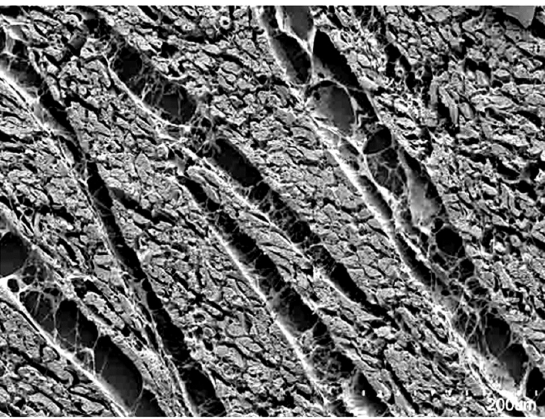
Figure 1. The scanning electron micrograph, taken from a sub-volume of the ventricular wall, shows how the individual cardiomyocytes are aggregated together by the endomysial component of the fibrous matrix into units that are separated by perimysial clefts containing loose connective tissue. There is, however, no uniformity in the thickness of the aggregated units, which can be seen to be heterogeneous and interconnected branching